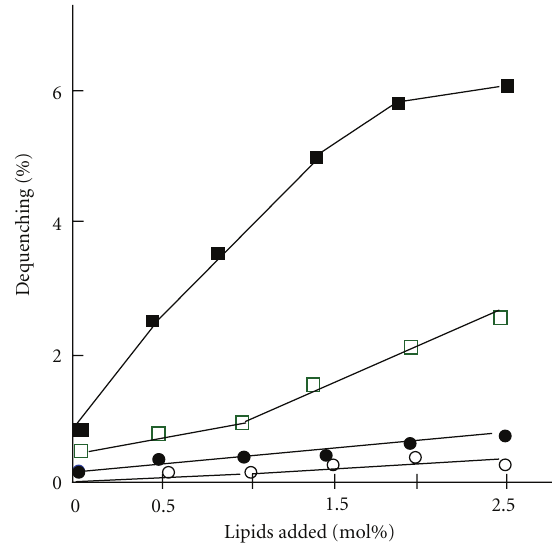
Figure 4: The e ff ect of M. fermentans lipids on the fusion of SUV with Molt-3 cells. Small unilamellar vesicles (SUVs) were prepared by sonicating a bu ff er solution containing egg-phosphatidylcholine (about 5mg permL) with various amounts of the glycophospho- lipid MfGL-II or the ether lipids MfEL or lyso-MfEL [37] as previously described [39]. The SUVs were fluorescently labeled with the octadecyl rhodamine B chloride (R18). Fusion of SUV with T-lymphocytes of the human CD4 + Molt-3 was monitored by following the fluorescence intensity of the Molt-3 cells, and the results were presented as % dequenching [40]. ( (cid:5) ): SUV alone; ( • ): SUV + MFGL-II; ( (cid:2) ): SUV + MfEL; ( (cid:3) ): SUV +